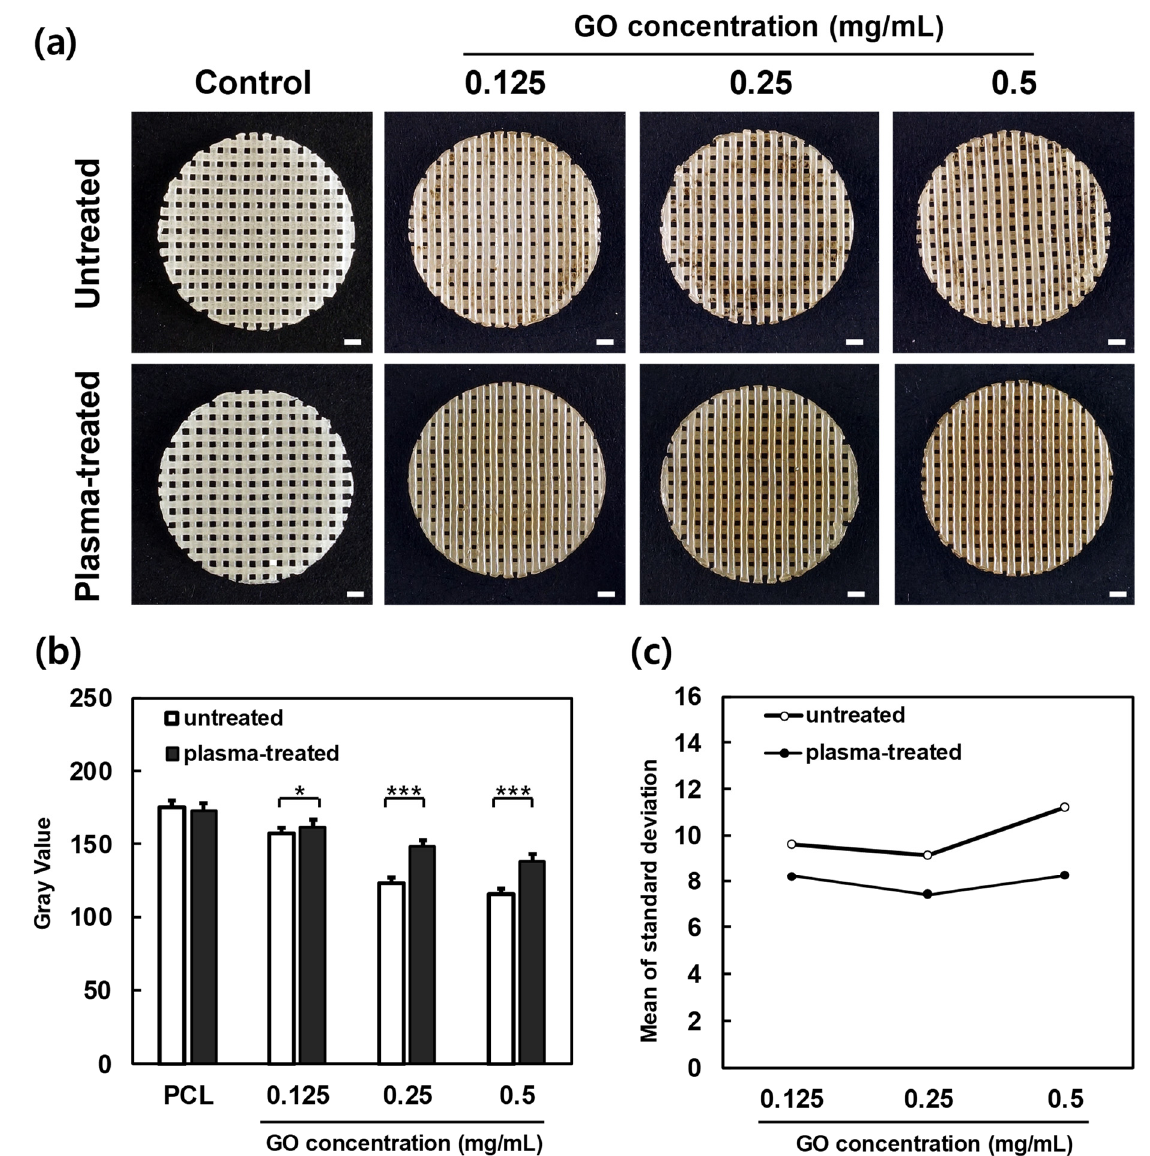
Figure 3. Image analysis of the scaffolds. ( a ) Images of PCL, PCL-GO at 0.125 mg/mL, PCL-GO at 0.25 mg/mL, PCL-GO at 0.5 mg/mL, PCL-plasma, PCL-plasma-GO at 0.125 mg/mL, PCL-plasma-GO at 0.25 mg/mL, and PCL-plasma-GO at 0.5 mg/mL scaffolds. Scale bars; 1.0 mm. ( b ) Pixel intensity by GO density (error bars indicate standard deviations, n = 5). ( c ) Mean of the standard deviation of pixel intensity by GO density (error bars indicate standard deviations, n = 5). * indicates a significant difference ( p < 0.05), *** indicates a significant difference ( p < 0.001).